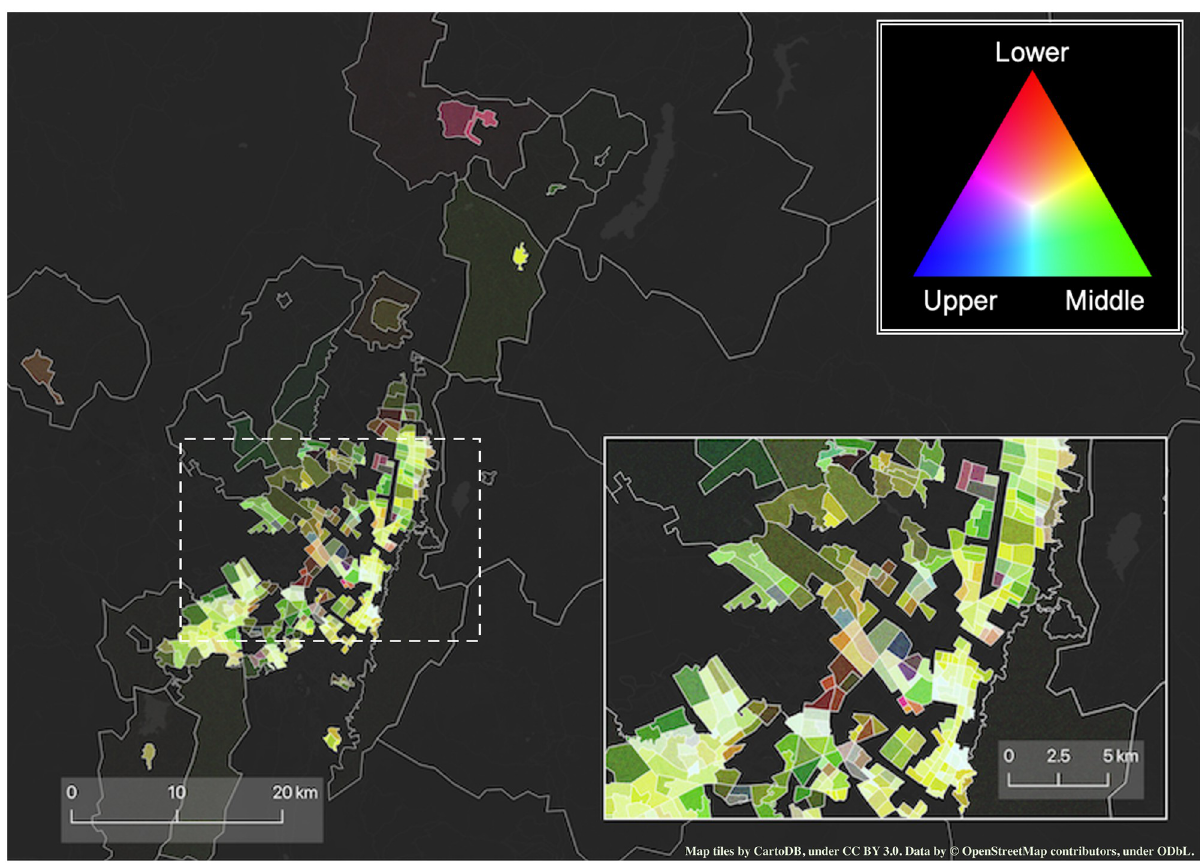
Fig 2. Density map of work travels made in BGT during the year 2019. Brighter colours represent a higher density of travels to work. The hue denotes whether for a given zone the majority of travels were made by travellers belonging to the lower (red), middle (green), upper (blue) or all three socioeconomic status. The inset portrays a zoom of the city centre. Figure contains information from OpenStreetMap and OpenStreetMap Foundation, which is made available under the Open Database License.